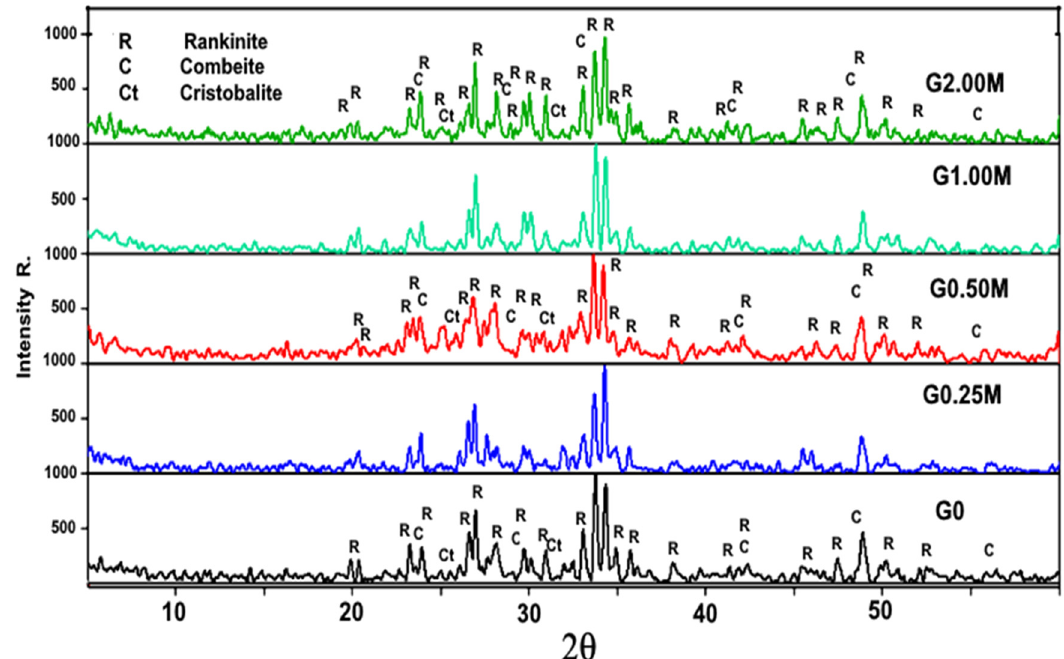
Figure 4: SEM micrographs of G0, G0.50M and G2.00M glasses sintered at 1,100°C/2